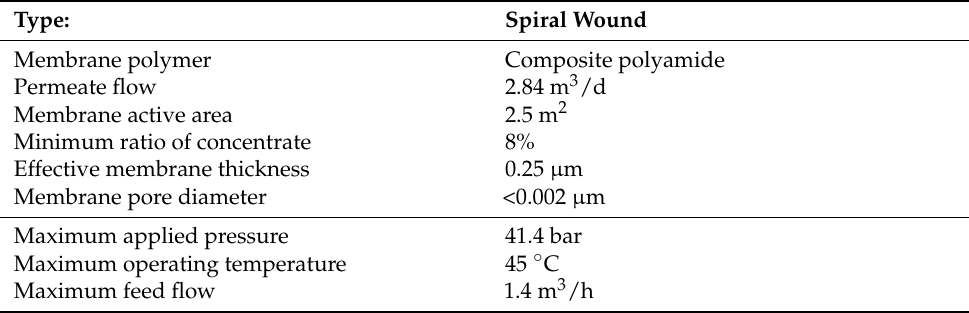
Table 1. Technical characteristics of the membrane